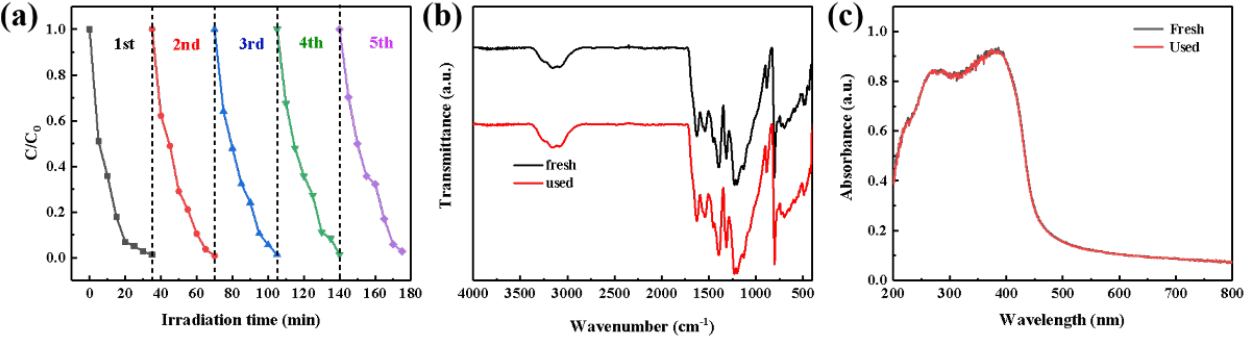
Figure 8. ( a ) Degradation performance of Fe-SACs/g-C 3 N 4 toward MBT over five cycles; ( b ) FT-IR; and ( c ) UV – vis spectra of fresh and used Fe-SACs/g-C 3 N 4 photocatalyst.